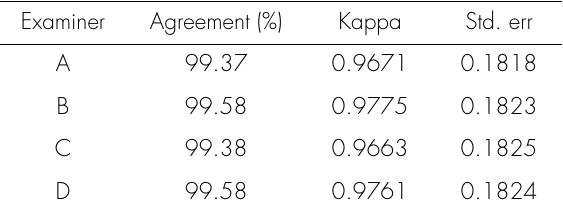
Table VI. Intra-examiner agreement and Kappa of the IOTN-DHC for the photographs of study